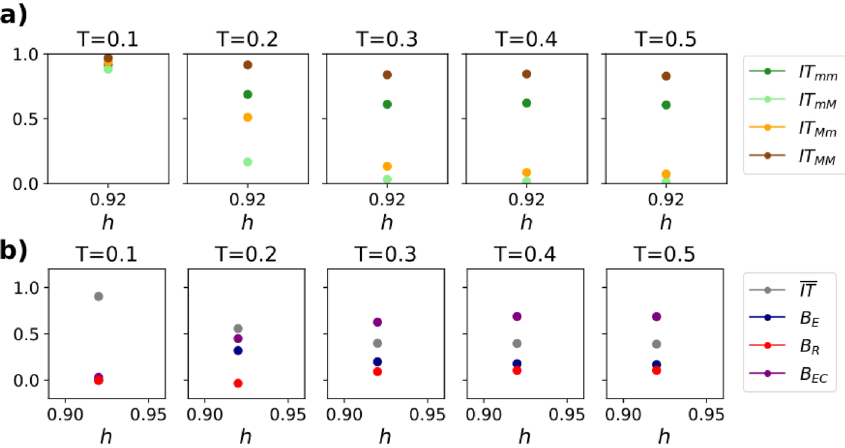
Figure 10. ( a ) Information transmission observables for Hybrid Contagion dynamics in a network of scientific citations between papers of the APS, for different thresholds T . The legend follows the same conventions as Fig. 5. Parameters of the network: h = 0.92 , f a = 0.3177 . ( b ) Bias variables corresponding to the IT observables of panel ( a